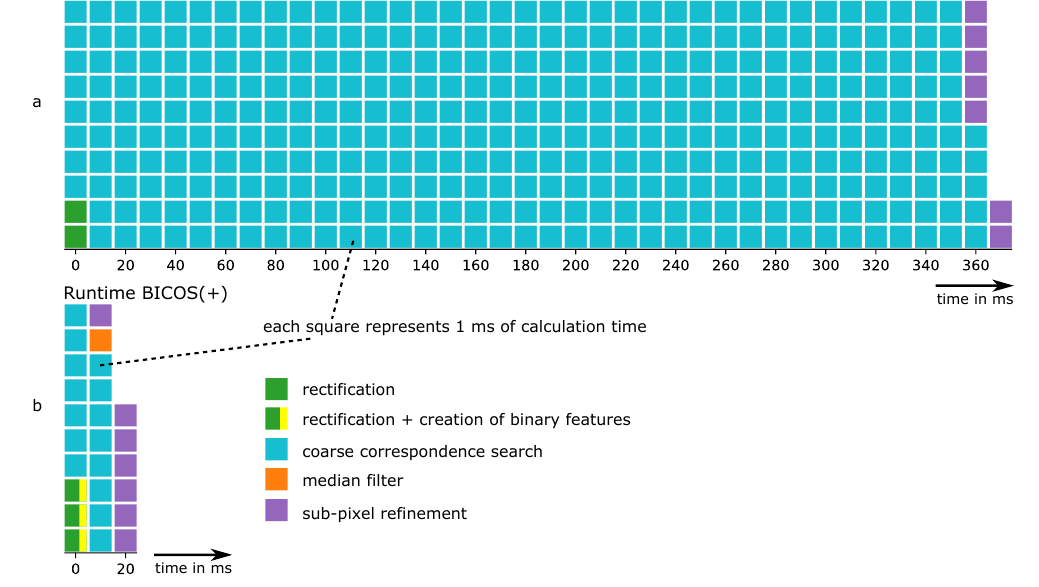
Figure 15. Algorithm runtime on NVIDIA GeForce 1080; each square represents one millisecond. ( a ) runtime of NCCCOS (reference algorithm), ( b ) runtime of